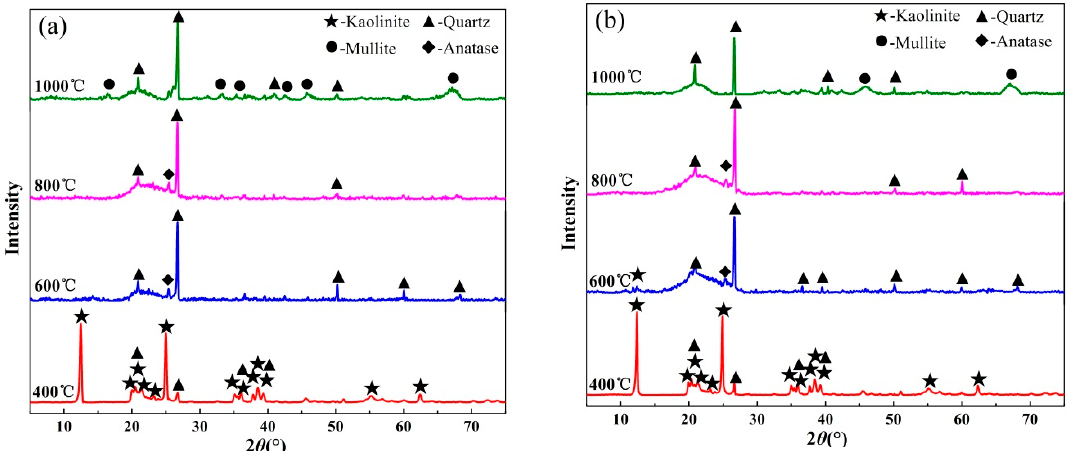
Figure 8. XRD patterns of calcined products by fluidized calcination ( a ) and static calcination ( b ) at various temperatures.